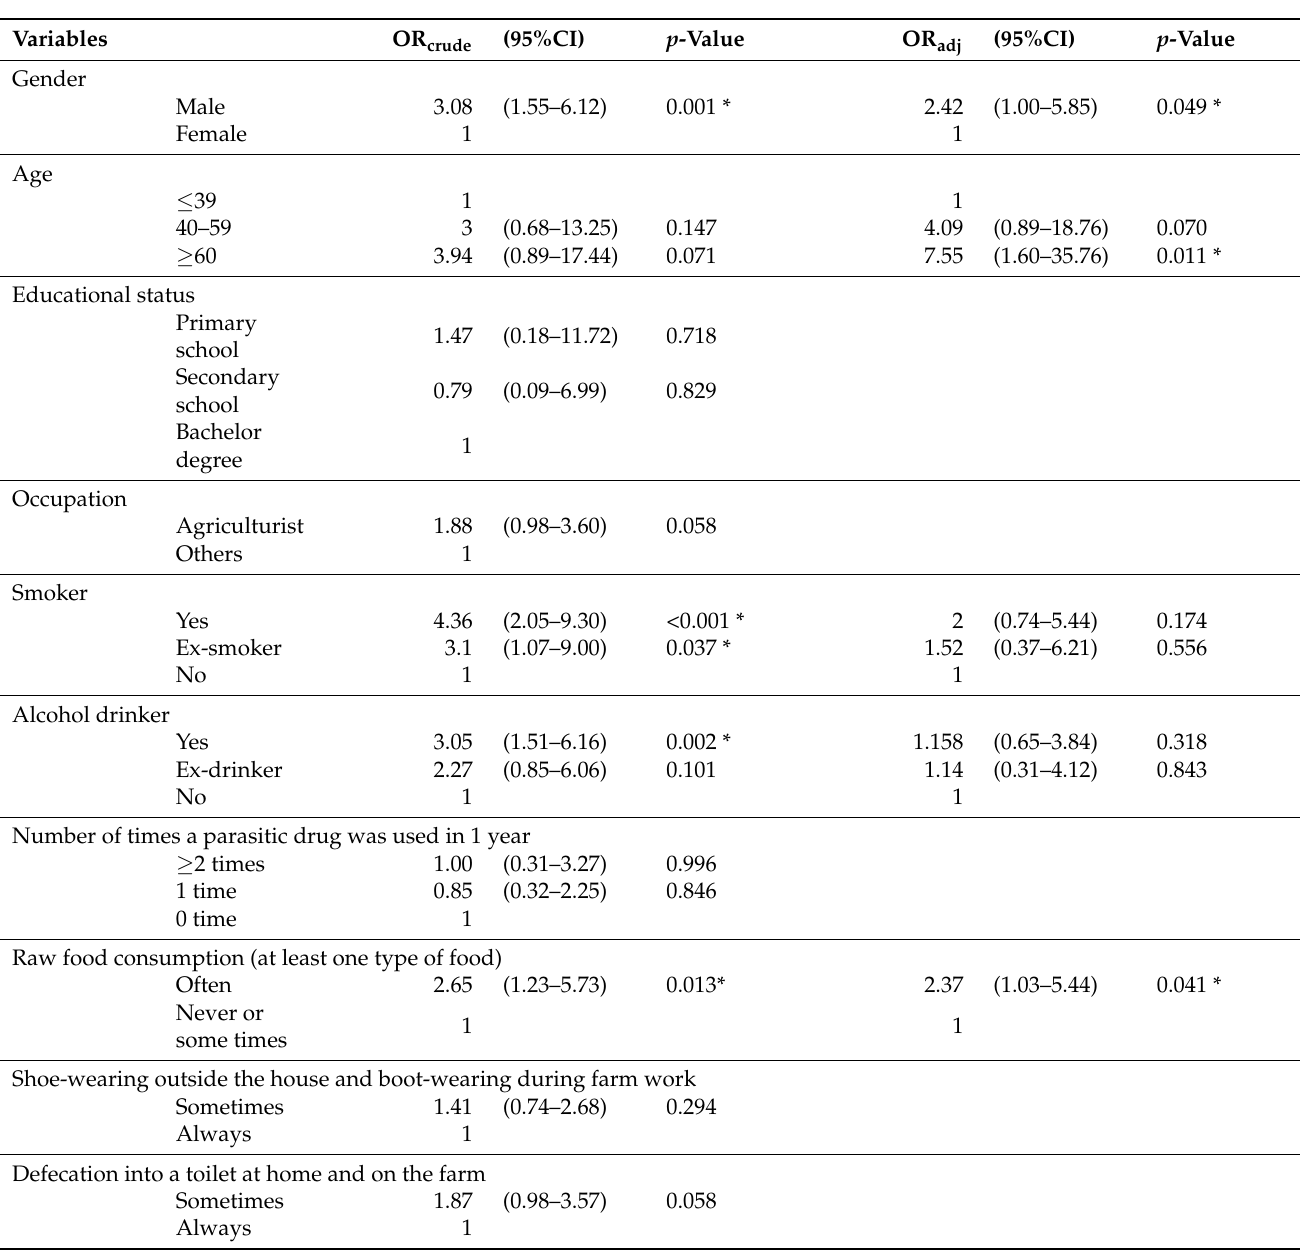
Table 3. The univariable and multivariable logistic regression analysis for parasitic infection in the